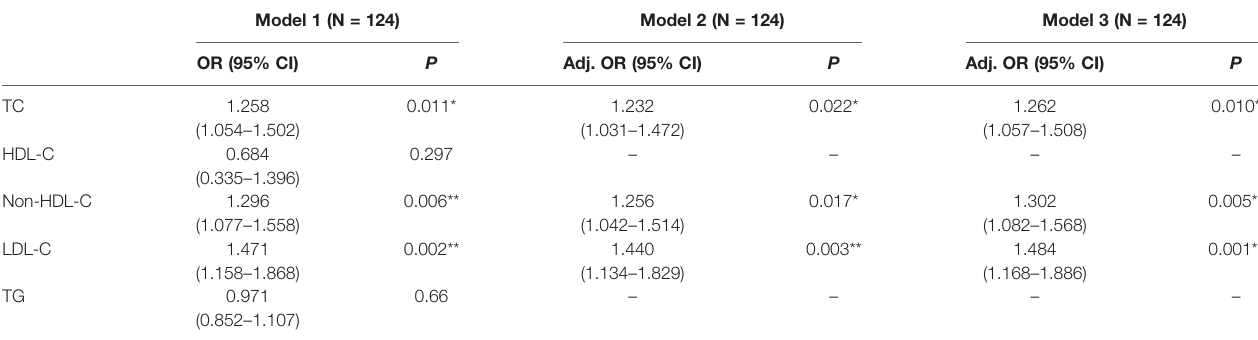
TABLE 5 | Logistic regression analyses for lipid pro fi les and seropositivity of the anti-PLA2R antibody.